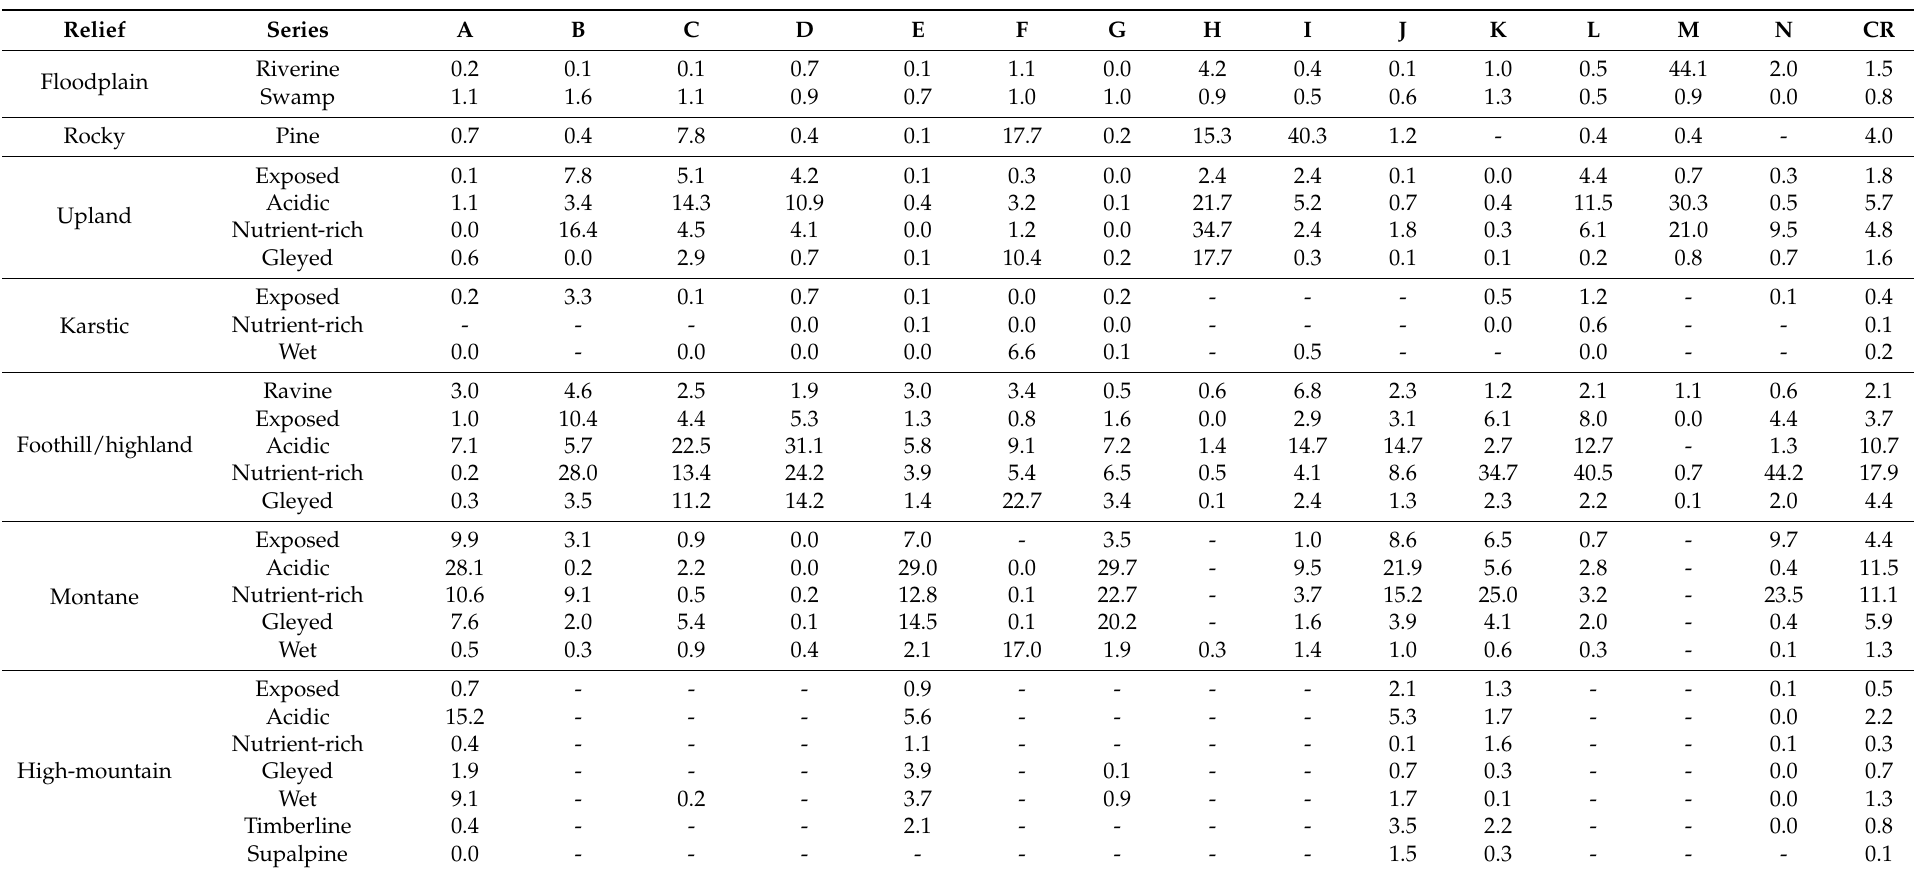
Table 1. Proportion of forest type management populations composed of relief types and soil series in forest area ranges of the Czech Republic (%). For an explanation of forest area ranges locations see Figure